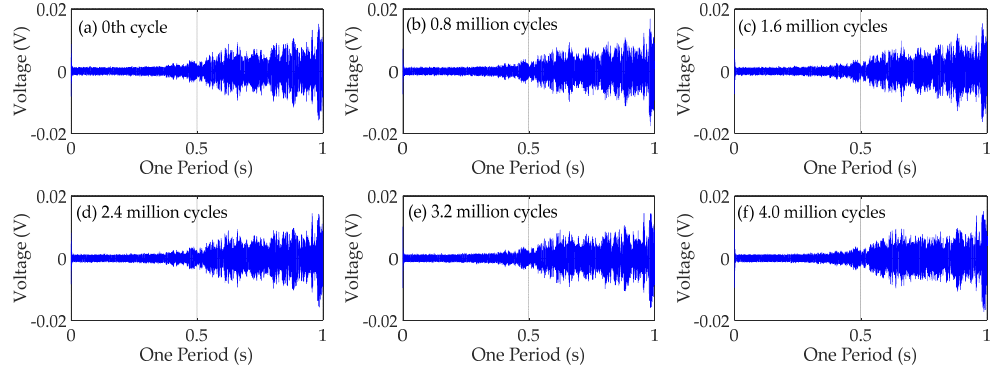
Figure 10. Time domain signals of PZT6 sensor for monitoring south side weld of CB/SB2 joint.